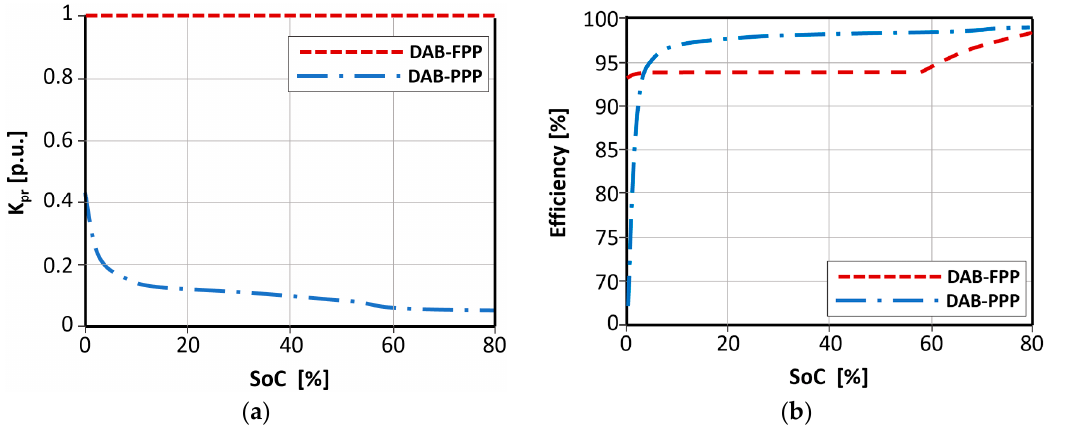
Figure 13. Comparison of DAB-FPP with DAB-PPP: ( a ) processed power ratio ( K pr ) vs. SoC; ( b ) effi- ciency vs. SoC